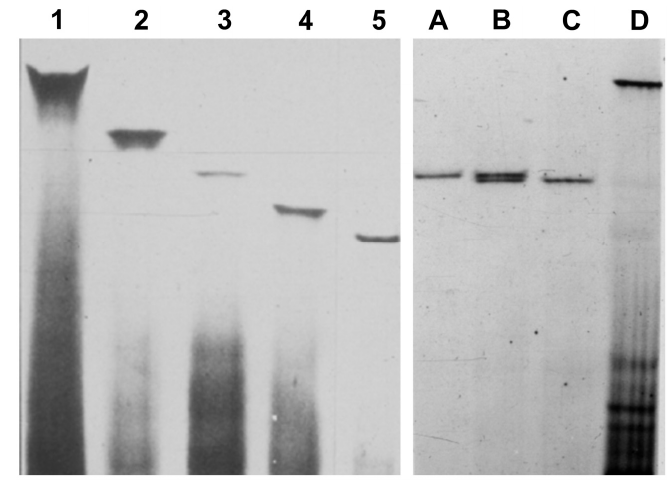
Figure 3. Analysis of inoculated Etrog citron plants by sPAGE and silver staining showing that they were infected with single viroids (1–5). CVd-II was not homogeneous but conformed by several bands ( A , C ) with slightly distinct electrophoretic mobilities ( B ) that were further characterized as specific variants of Hop stunt viroid (HSVd) showing faster mobility than CEVd ( D ).